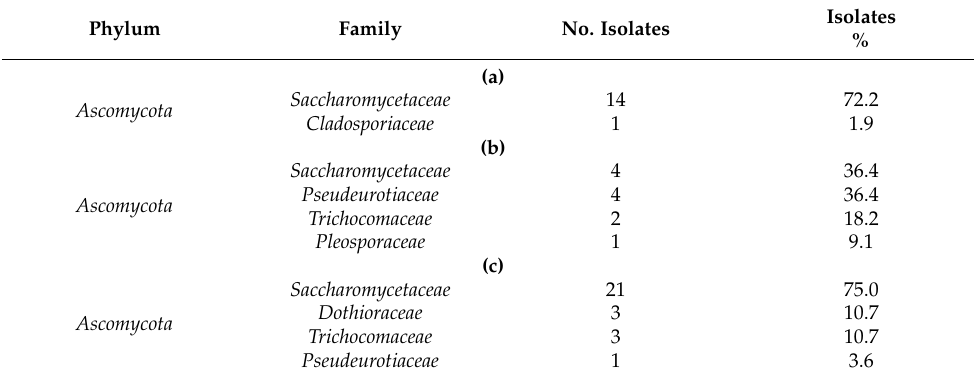
Table 2. Fungal diversity frequencies by phylum and family level of isolated from bat samples (oral and skin swab) at each cave: (a) Geum; (b) Eun; (c) Handemy. Saccharomycetaceae was the most frequently isolated.